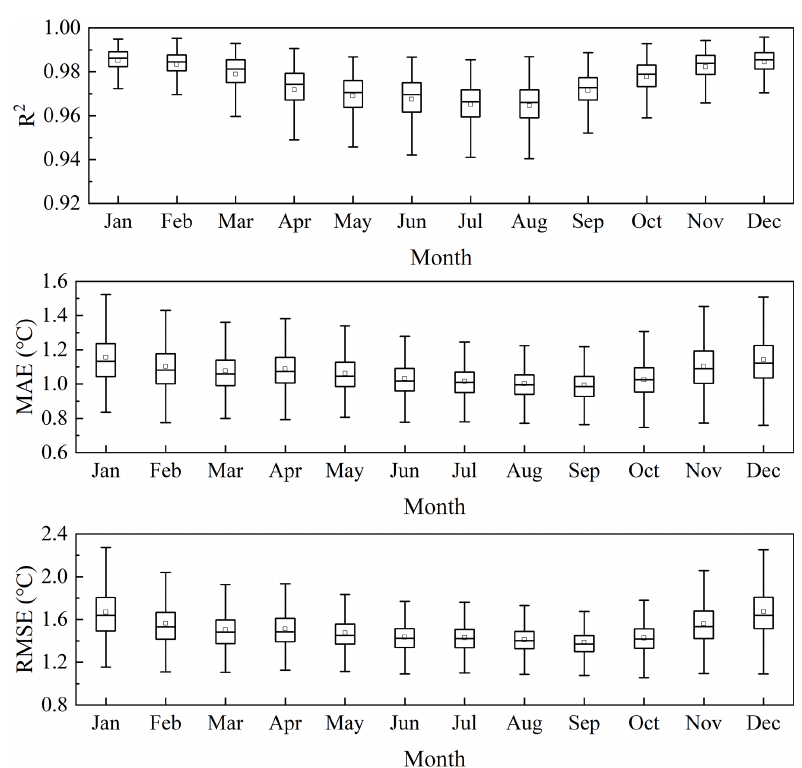
Figure 8. Box plots of the R 2 , MAE and RMSE of T max after correction for each month in the whole China region.